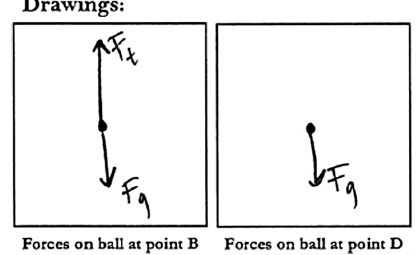
FIG. 6. Free-body diagram accompanying student response to coin toss question.